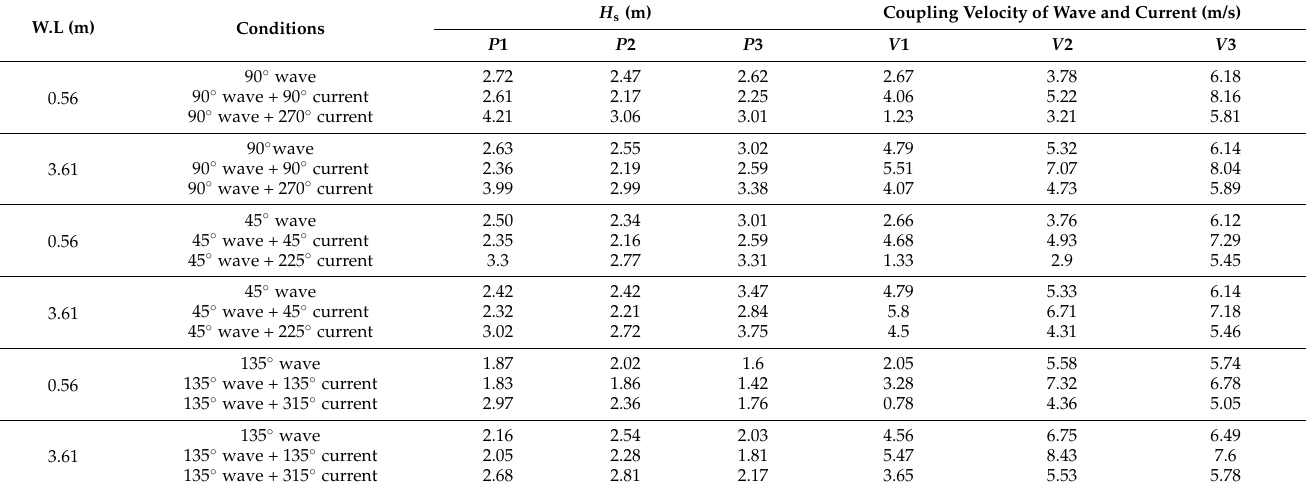
Table 2. Results of wave height and velocity at the junction under different wave–current